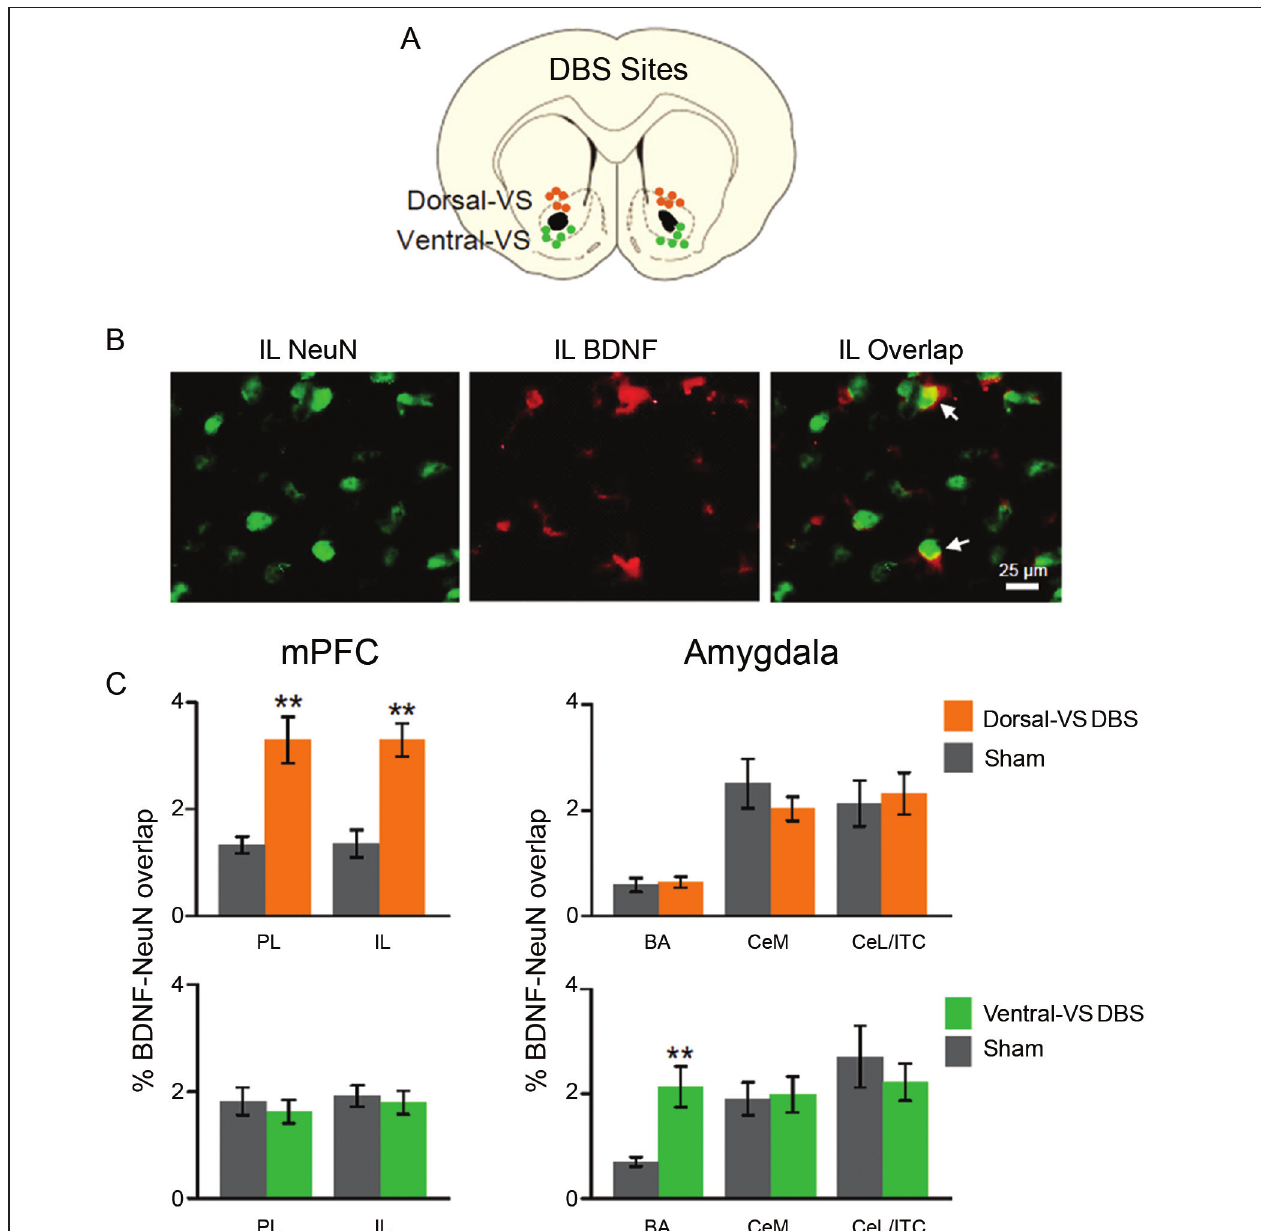
DBS of dorsal-VS, n = 6). In contrast, DBS of ventral-VS increased BDNF-NeuN overlap in BA, but not in PL, IL, CeM or CeL/ITC (Sham, n = 5; DBS of ventral-VS, n = 5). Legend: CeM = medial portion of the central nucleus of the amygdala, CeL = lateral portion of the central nucleus of the amygdala, ITC = intercalated cells. Data shown as mean and SEM. ∗∗ p <